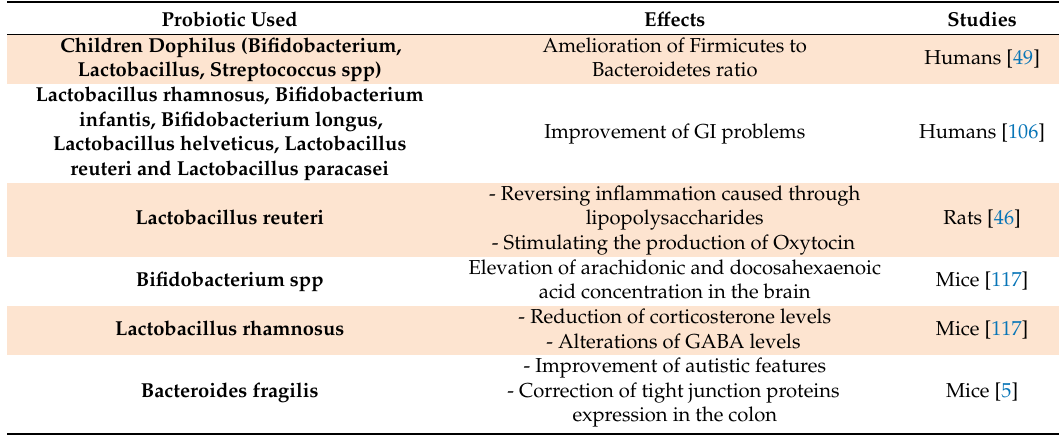
Table 3. Non-exhaustive list of reports studying the e ff ects of probiotics supplementation in ASD. Probiotic